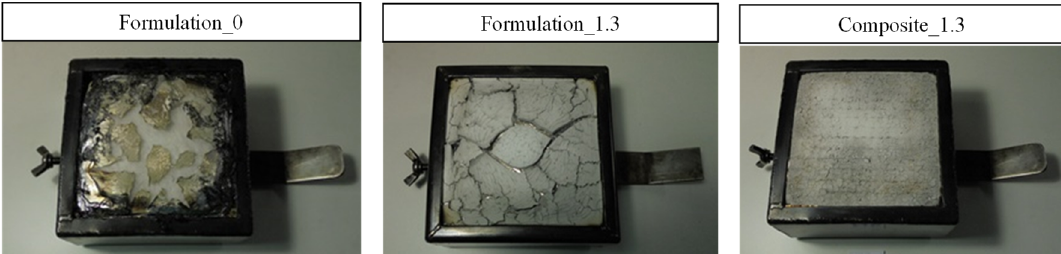
Figure 7. Representative examples of specimens after calorimetric cone experiments.